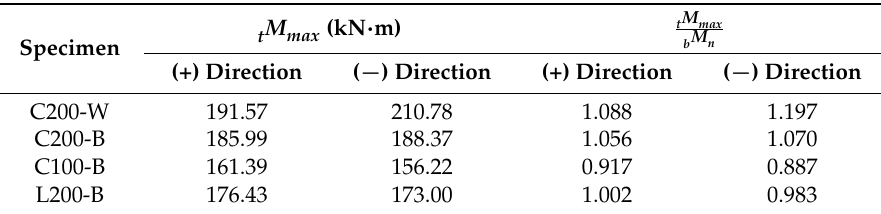
Table 6. Maximum strength of the test specimens.